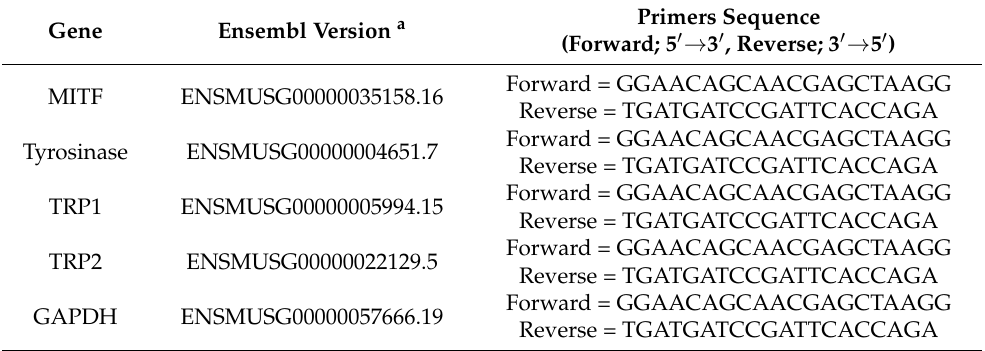
Table 1. Primer sets used for real-time